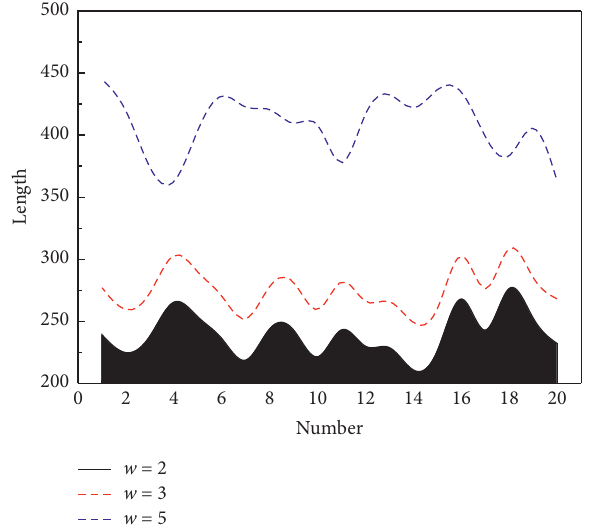
Figure 6: Comparison of path lengths of optimization algorithms.